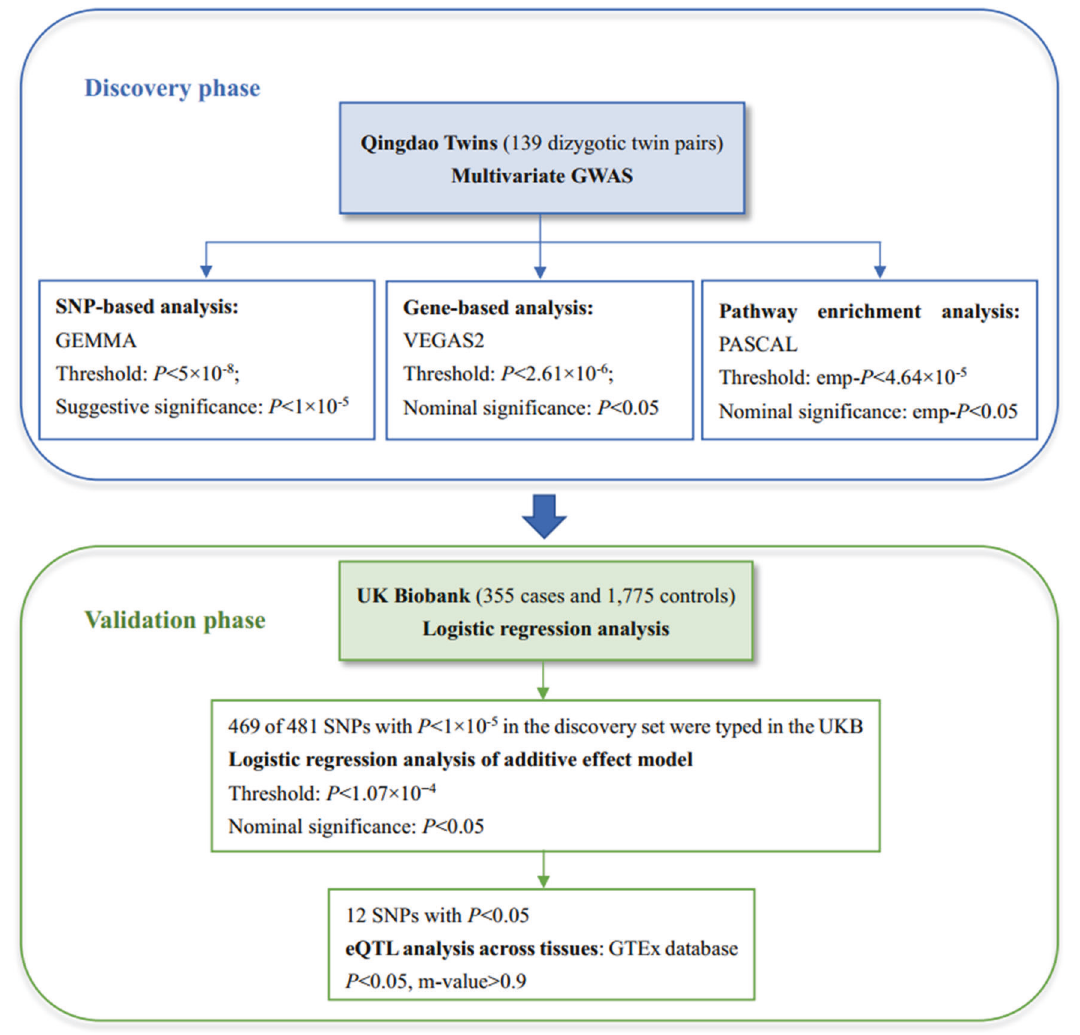
Fig. 1 Flowchart of the overall study design and analysis